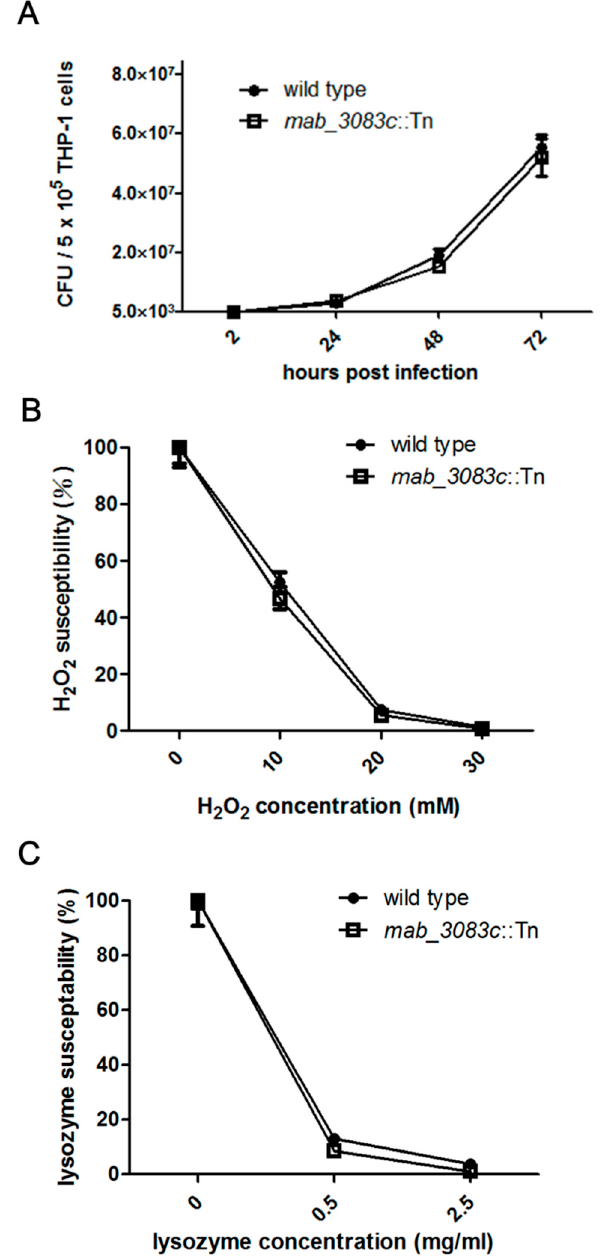
Figure 3. Intracellular survival and susceptibility to hydrogen dioxide and lysozyme of wild type and mab_3083c::Tn strains of M. abscessus . ( A ) Intracellular survival of M. abscessus . THP-1 cells were co-cultured with bacterial cells of wild type or mab_3083c ::Tn mutant at MOI of 1 for 2, 24, 48, or 72 h at 37 °C. The infected THP-1 cells were washed and lysed, and the numbers of survived intracellular M. abscessus cells were determined at the indicated time points. ( B ) Susceptibility